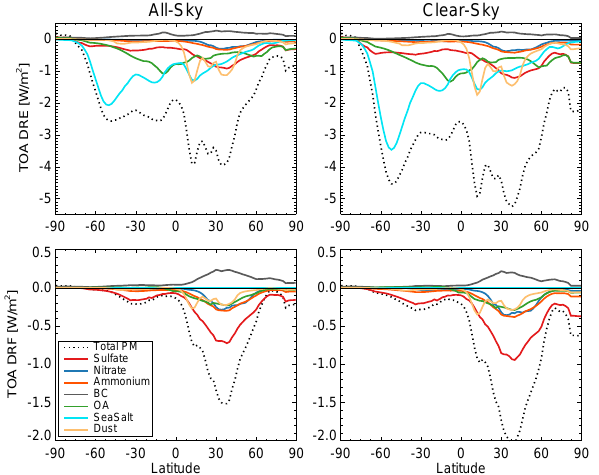
Figure 5. Global seasonal mean speciated aerosol TOA direct ra- diative effect (top) and direct radiative forcing (bottom) for all-sky (left) and clear-sky (right) simulated by GC–RT for